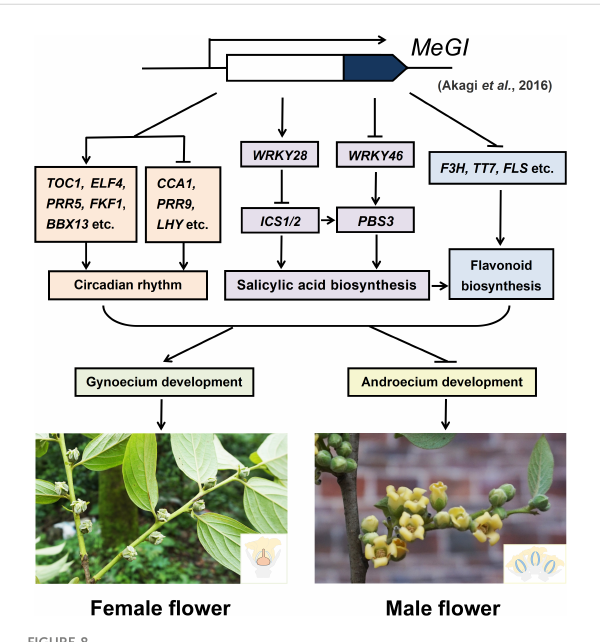
FIGURE 8 Model of MeGI -mediated sex determination in D. oleifera